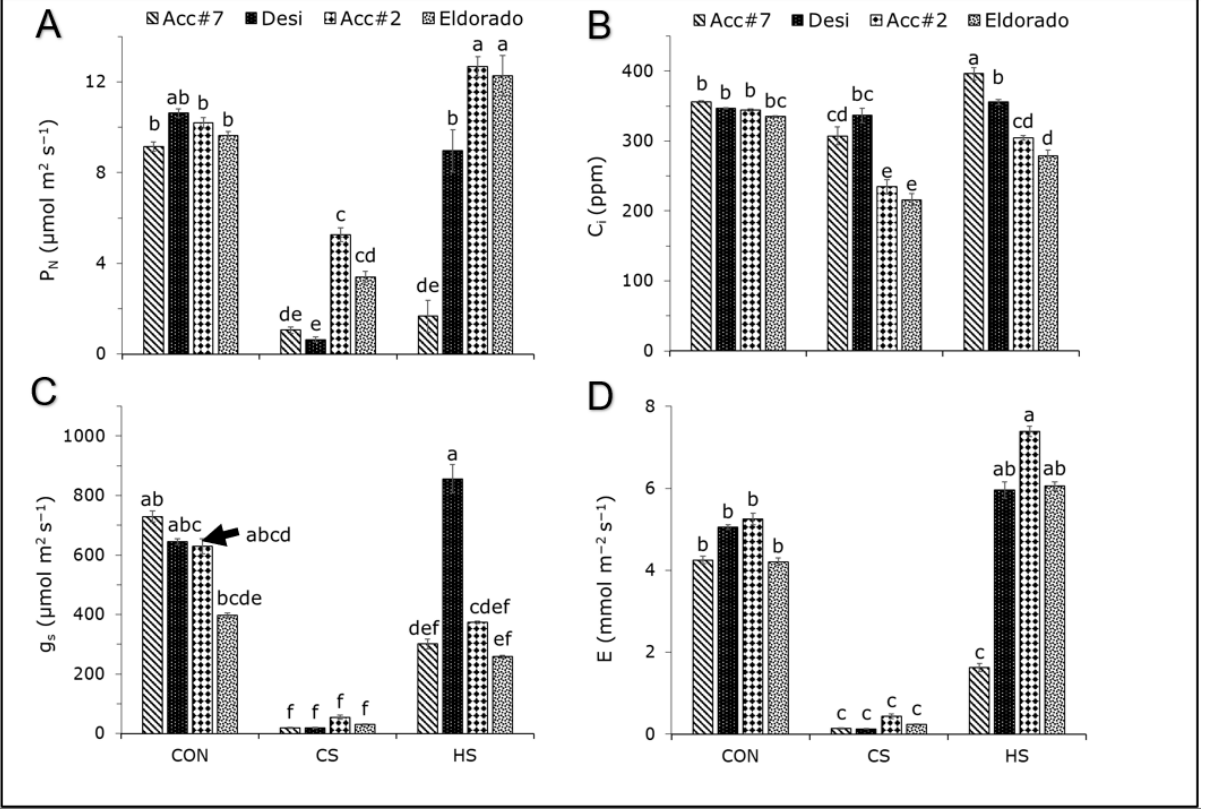
Figure 2. ( A ) Net photosynthetic rate (P N ), ( B ) intracellular CO 2 (C i ), ( C ) stomatal conductance (g s ) and ( D ) transpiration rate (E) in the second fully expanded top leaves of four chickpea genotypes under the treatments for 3 days. “CON”, 25/20 ◦ C day/night; “CS”, 8/4 ◦ C day/night; “HS”, 38/33 ◦ C day/night. The data represent average values ± SD ( n = 3). Different small letters above the bars indicate significant differences ( p < 0.05). The arrow is indicating that the letters abcd belong to Acc#2 under control